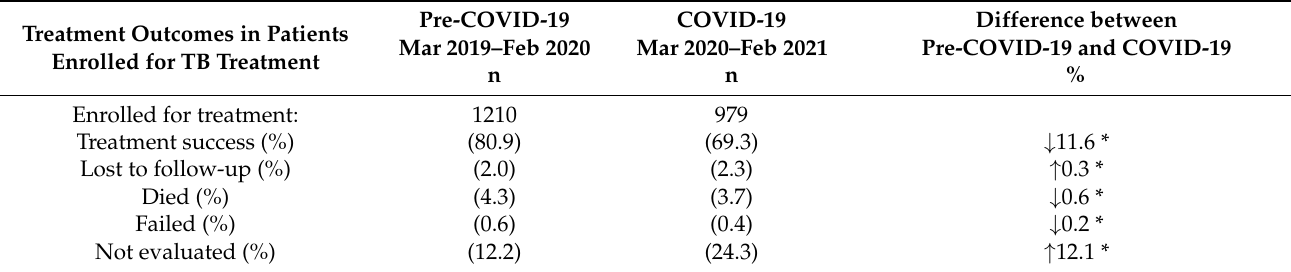
Table 2. Treatment outcomes of patients enrolled in TB treatment in 10 health facilities in Harare, Zimbabwe, during pre-COVID-19 and COVID-19 periods.